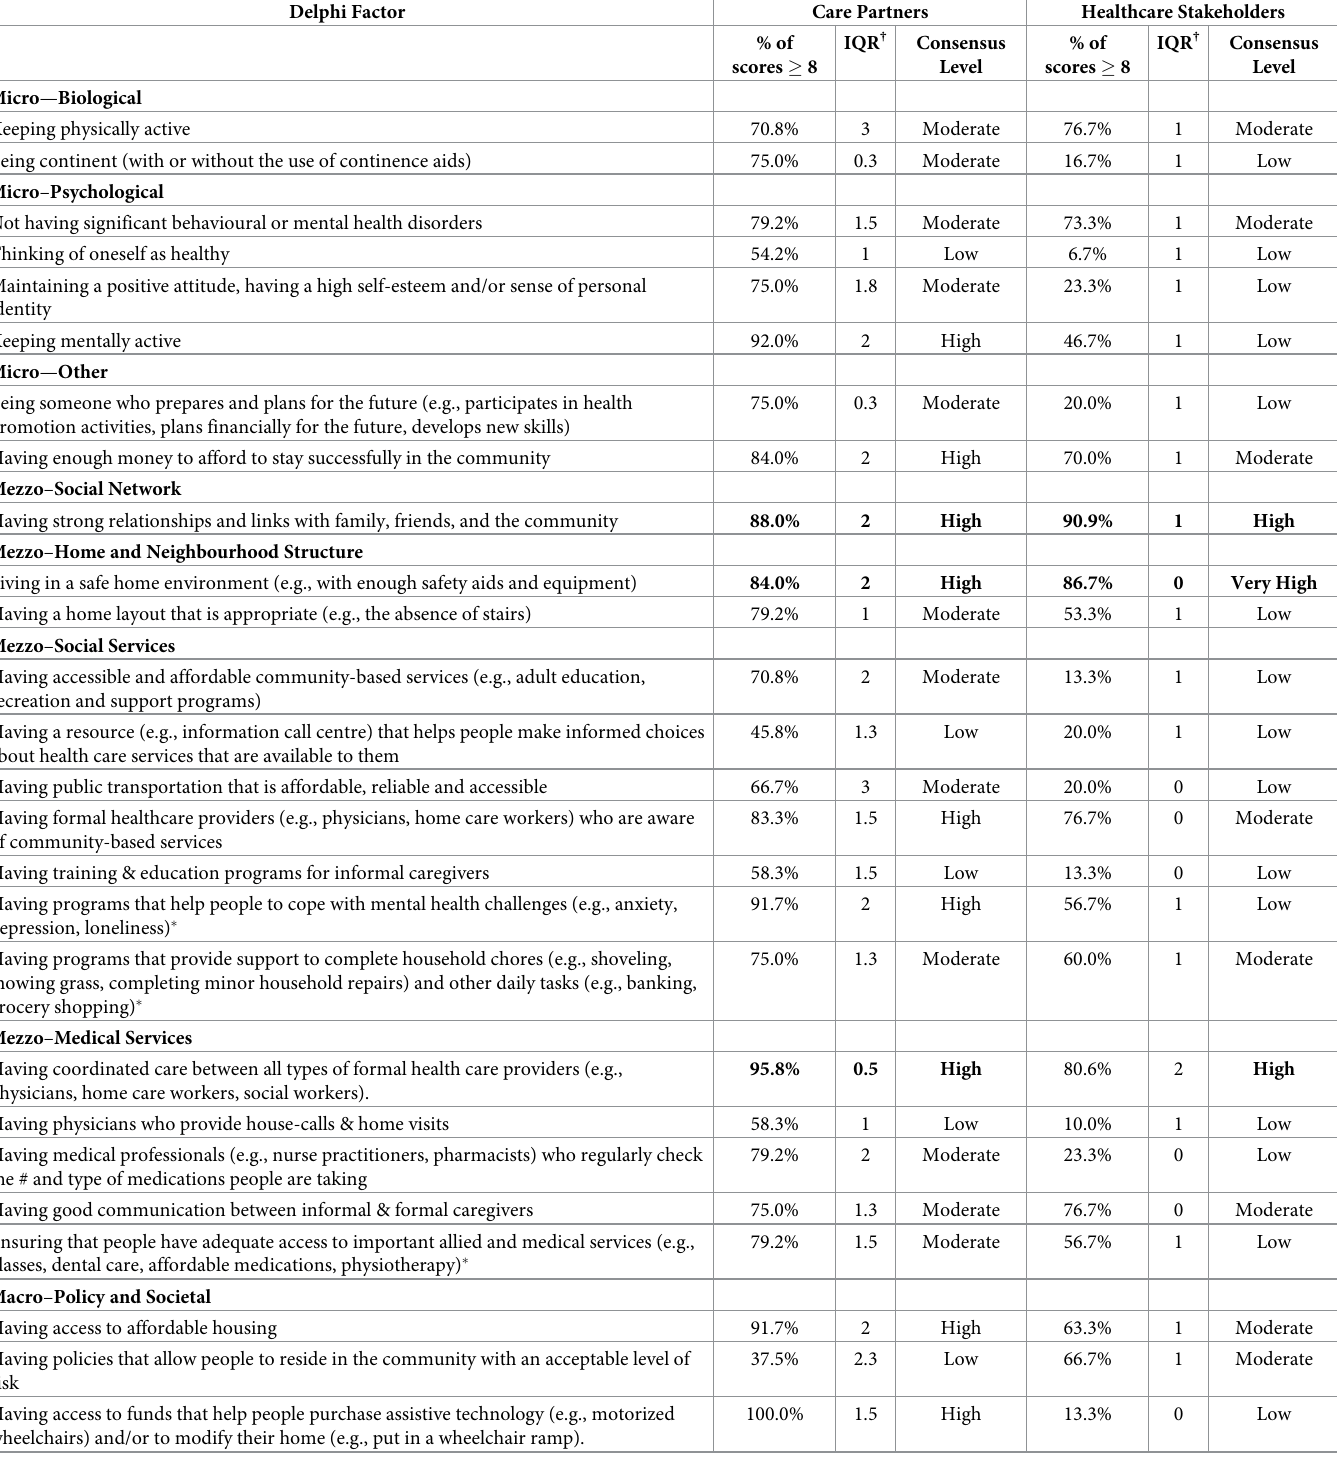
Table 3. Final consensus results by factor and participant